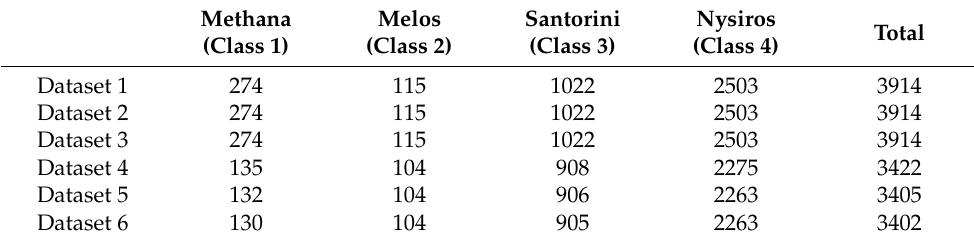
Table 2. Classes and entries of Datasets